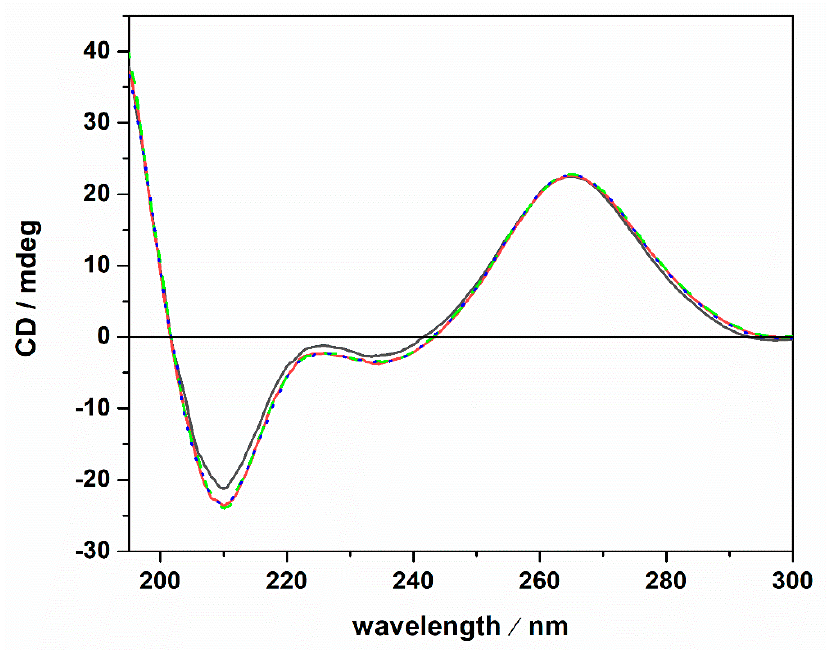
Figure 3. Circular dichroism spectra of a 20 µ M tRNA solution in the absence (black spectrum) and in the presence of 1 mM MgCl 2 (red spectrum), MgSO 4 (dotted blue spectrum) and Mg(ClO 4 ) 2 (green dashed spectrum). All the experiments were carried out at the temperature of 25 °C in 20 mM Tris-HCl buffer, 40 mM KCl, pH 6.9, using a 0.1 cm path length quartz cuvette.